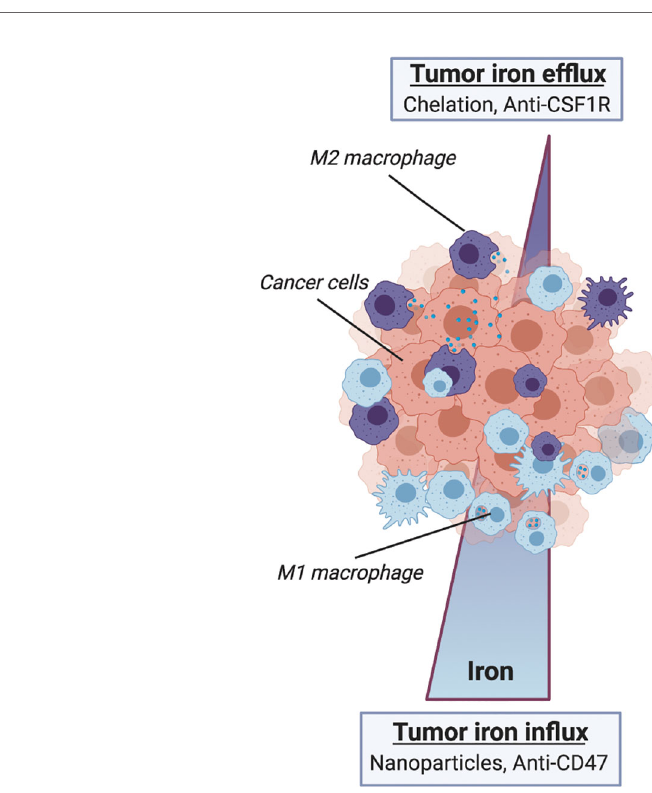
FIGURE 3 | Macrophage iron metabolism and immune response in the tumor microenvironment. Within the microenvironment macrophage phenotype is in fl uenced by iron metabolism, and both iron and immune status are correlated with tumor growth and therapy response. Along a gradient of tumor iron concentration established according to systemic metabolic background and mode of therapy, macrophages can adopt various polarization states spanning a continuum between M1 anti-tumor/proin fl ammatory activation and M2 pro-tumor wound-healing states. Low tumor iron is associated with reduced tumor growth and favors M2-like macrophage polarization with increased expression of ferroportin, lipocalin 2 and transferrin receptor, and reduced ferritin content. High tumor iron is similarly associated with reduced tumor growth and favors M1-like macrophage polarization with lower expression of ferroportin, lipocalin 2 and transferrin receptor, and increases in ferritin iron storage. Between these two extremes the heterogeneous distribution of macrophage polarization states supports an intermediate iron regime where iron-addicted cancer cells expressing low levels of ferroportin, and high levels of ferritin, lipocalin 2 and transferrin receptor co-opt macrophage ’ s innate role in iron handling to support